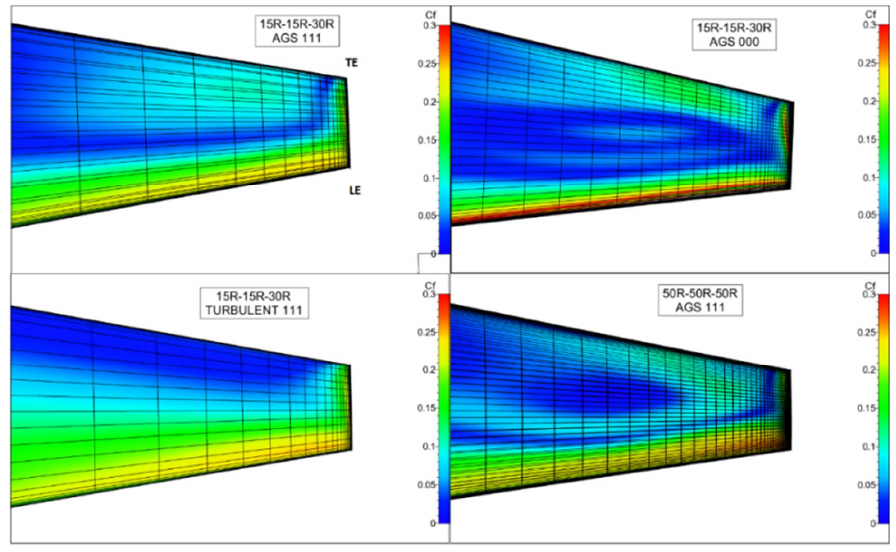
Figure 26. Skin-friction contours in the top 15% span of the suction side, showing mesh density for several 3D domain sizes and transition models of the solo propeller rotating downwards.